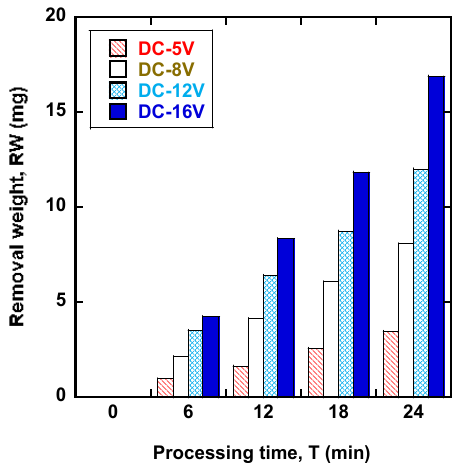
Figure 7. Material removal weight vs. Processing time.